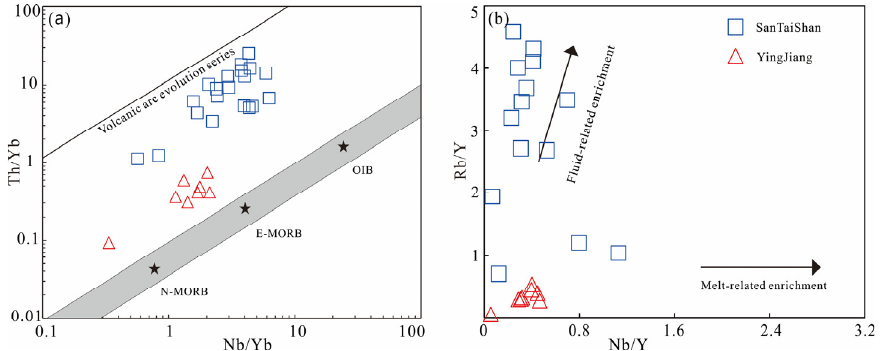
Figure 10. ( a ) Nb/Yb–Th/Yb diagram (modi fi ed from [66]); ( b ) Nb/Y–Rb/Y diagram (modi fi ed from